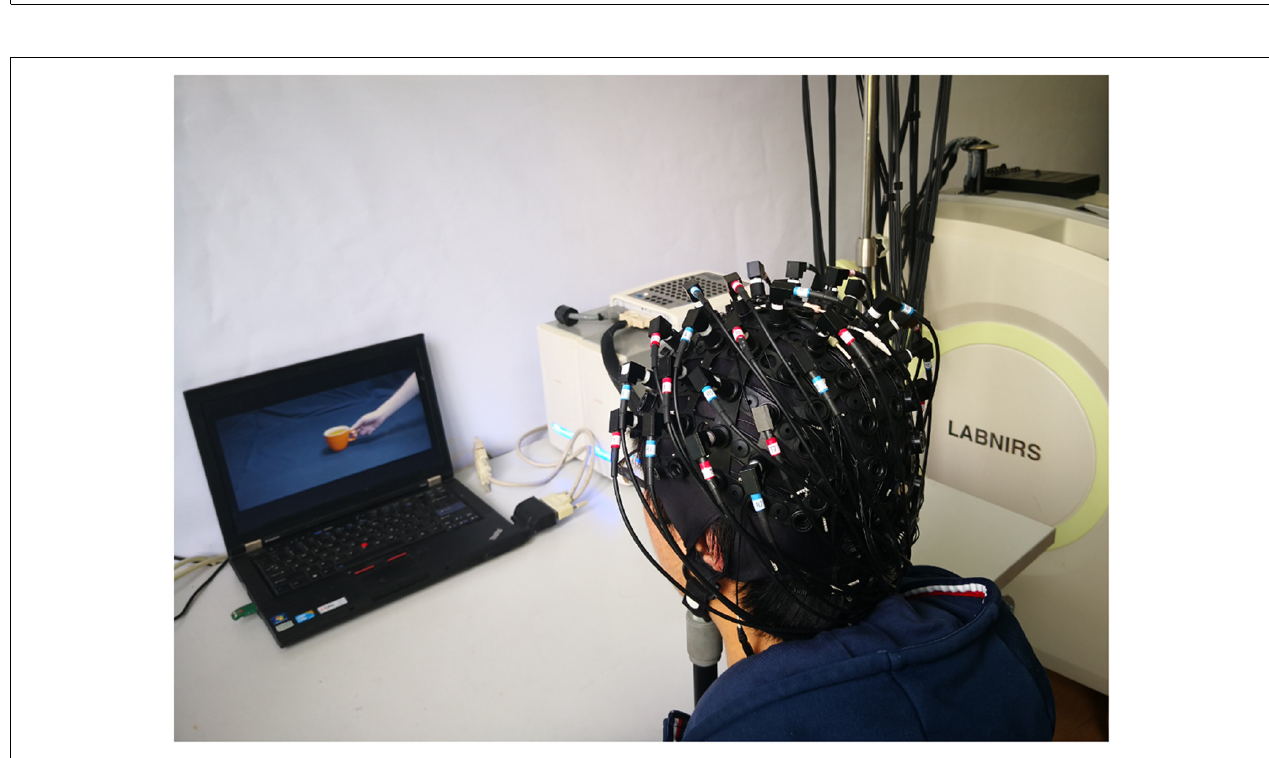
FIGURE 1 | Three kinds of hand-cup interaction stimuli corresponding to different potential intentions. (A) a right hand grasping the handle of the cup with the intention to drink from it (Sd); (B) a right hand grasping the rim of a cup with the intention to move it (Sm); (C) a right hand touching the rim of a cup without a clear intention (Su).